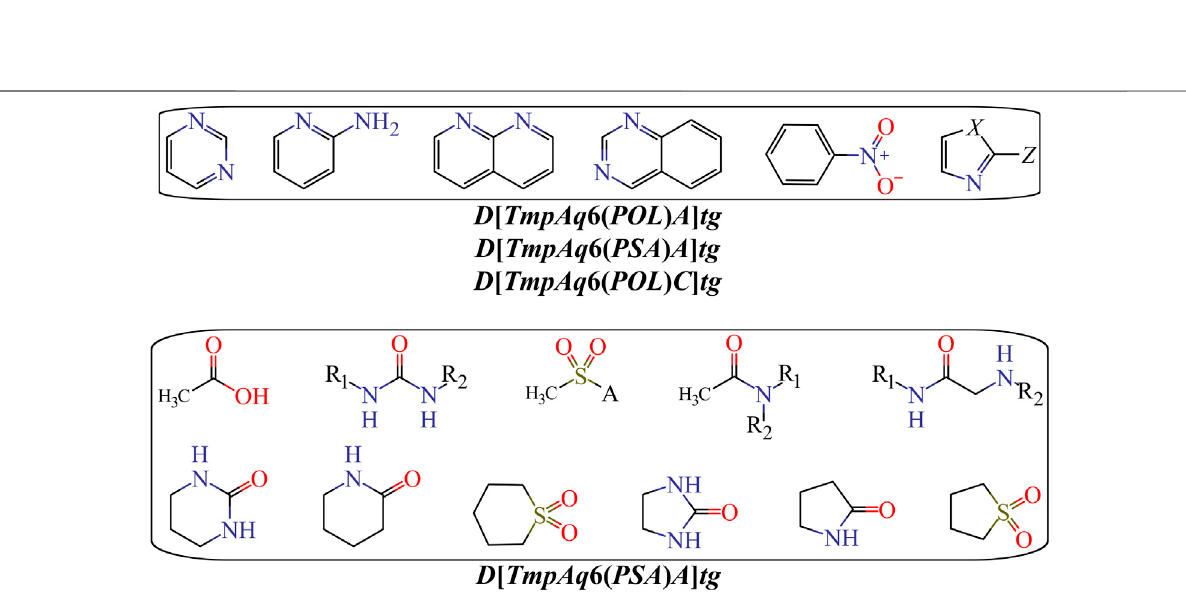
Frontiers in Chemistry |